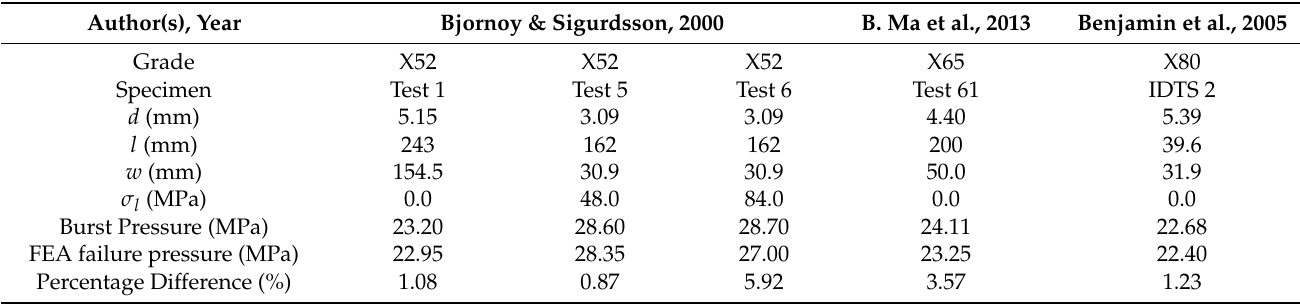
Table 4. Summary of FEA failure pressure validation against full-scale burst tests for pipes subjected to internal pressure only, and internal pressure and axial compressive stress, data from